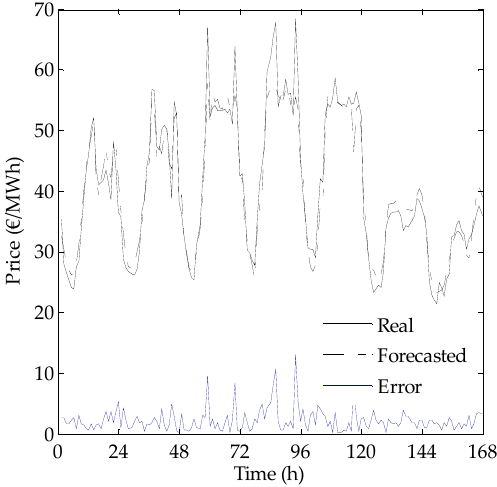
Figure 7. Summer week 2002 results for the Spanish market.